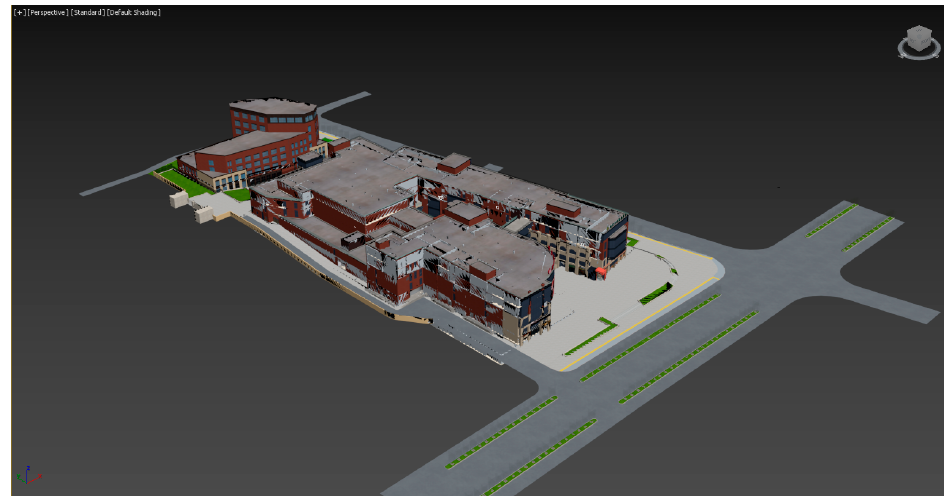
Figure 4. View the Building Information Modeling (BIM) model of the commercial Guanlan Street in Baiyin City in 3D MAX.